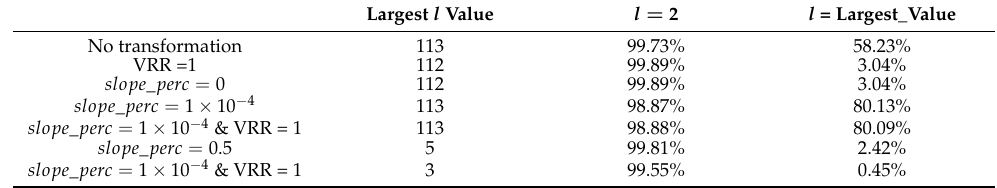
Table 7. Ambiguity-value metric under different transformation values for the Mercari